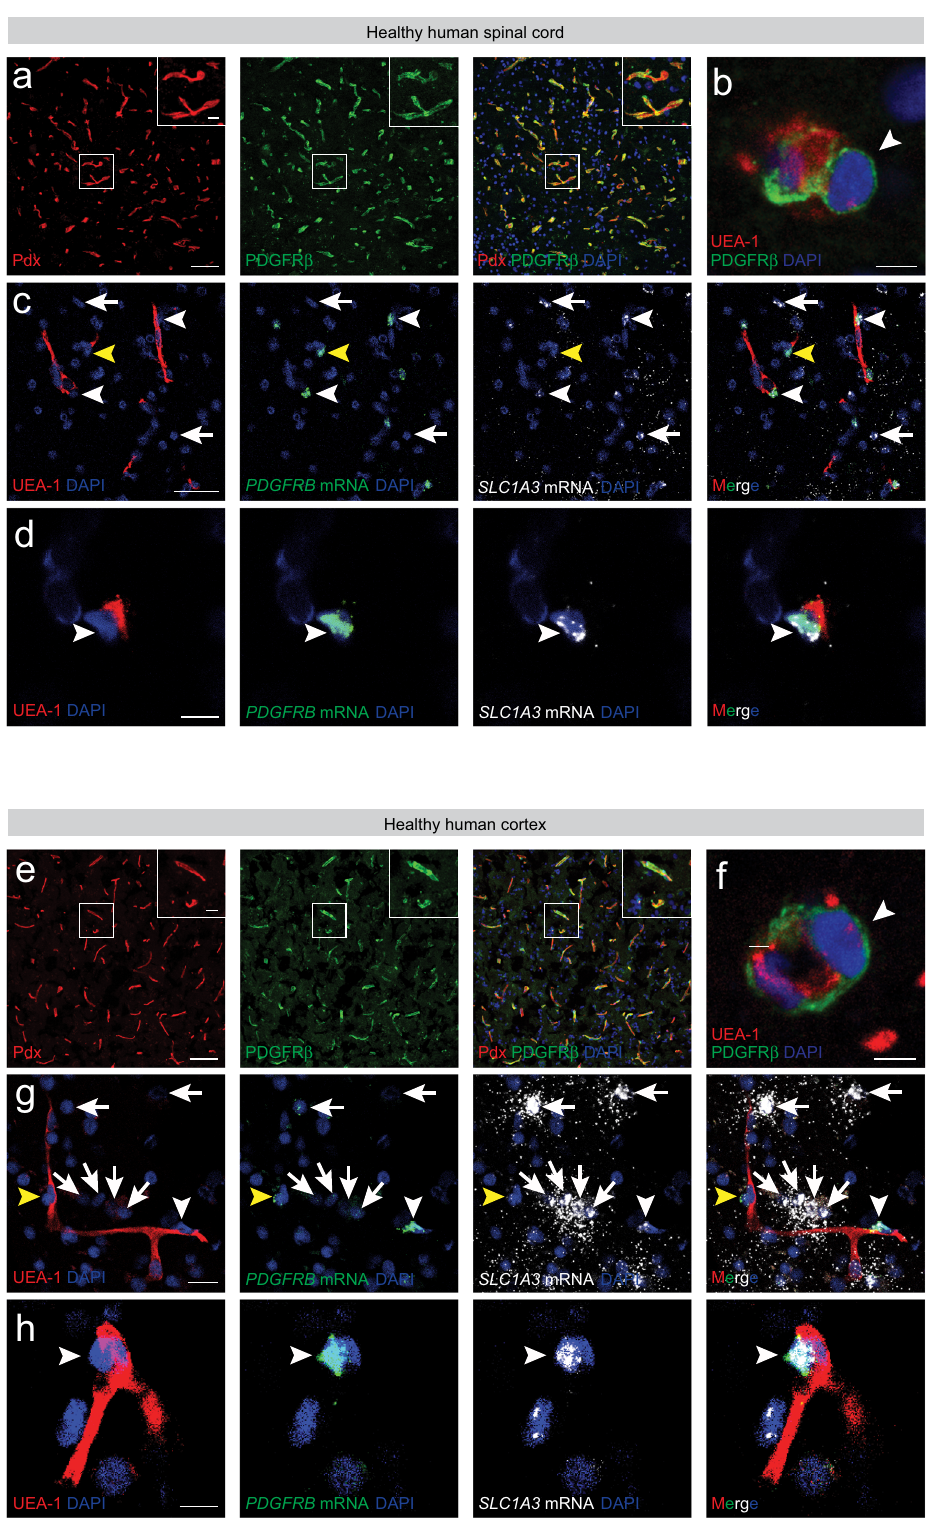
the right MCA was exposed and occluded by cauterization. The artery was then cut off to be sure that there was no remaining blood fl ow to the corresponding cortical region. After the skin had been sutured, mice were injected with 0.5ml Ringer ’ s solution, returned to their home cages, and placed on a heating pad. Permanent occlusion of the distal portion of the MCA led to ischemic lesions con fi ned to the cerebral cortex (cortical stroke). Only male mice were used. GLAST- CreER T2 ;R26R-tdTom animals were sacri fi ced at 5 days ( n = 4) and 14 days ( n = 4) after cortical stroke induction. The contralateral side to the lesion served as control ( n =